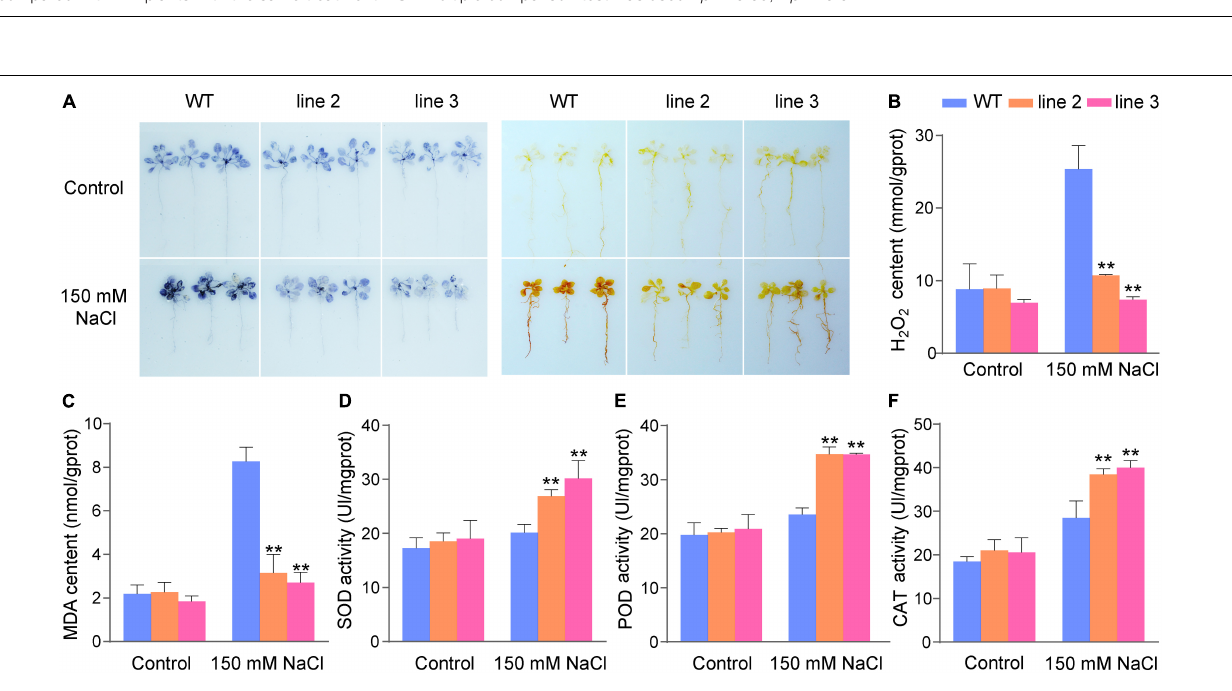
Frontiers in Plant Science |